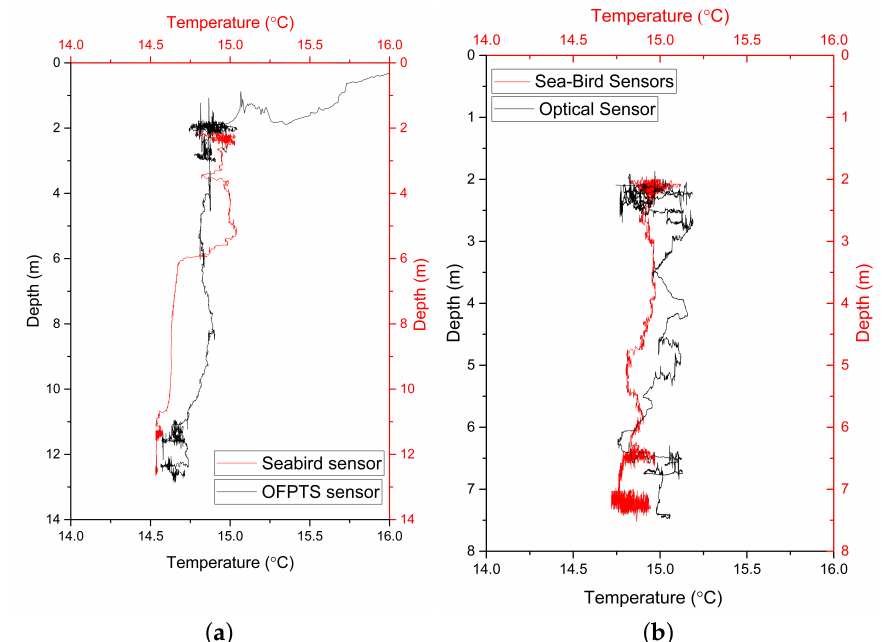
Figure 6. Depth and Temperature graph in comparison to the reference sensor ( a ) Deployment station NMEA (National Marine Electronics Association) Latitude = 51 49.54 N, NMEA Longitude = 008